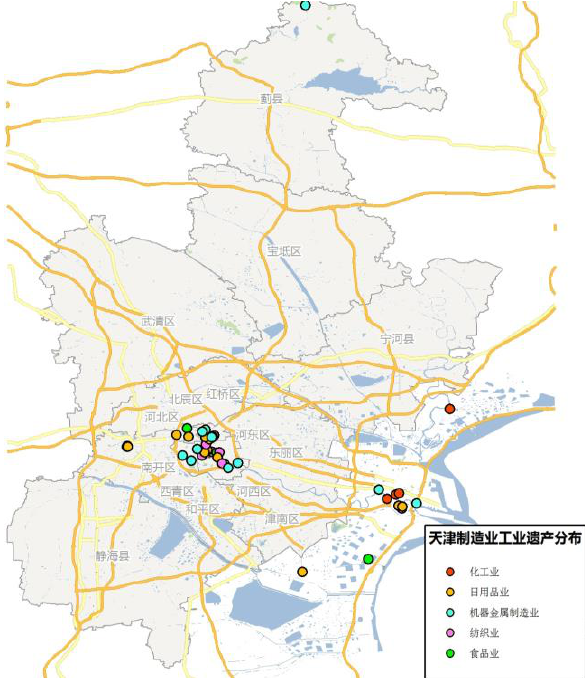
Figure 4. Spatial distribution and industry types of the industrial heritages in Tianjin